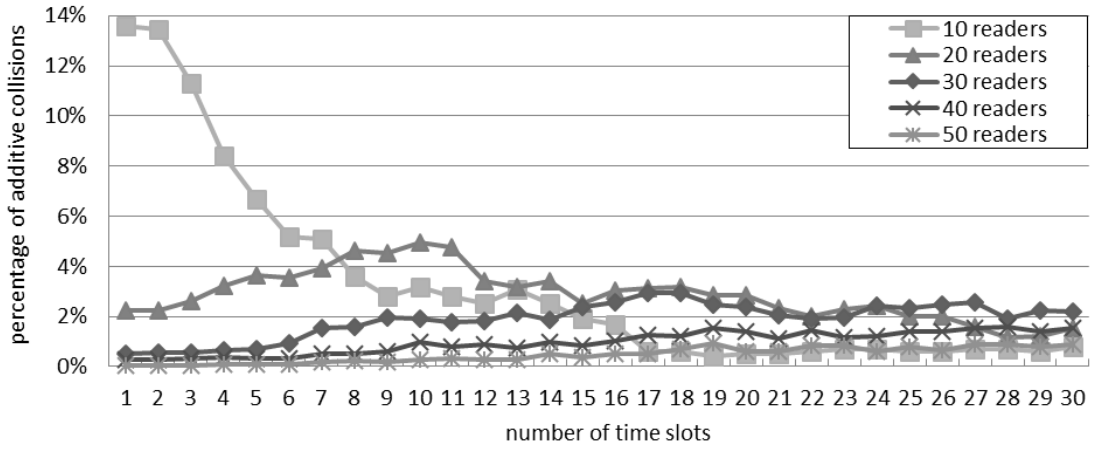
Figure 8. Ratio of additive collisions with the slotted interrogation